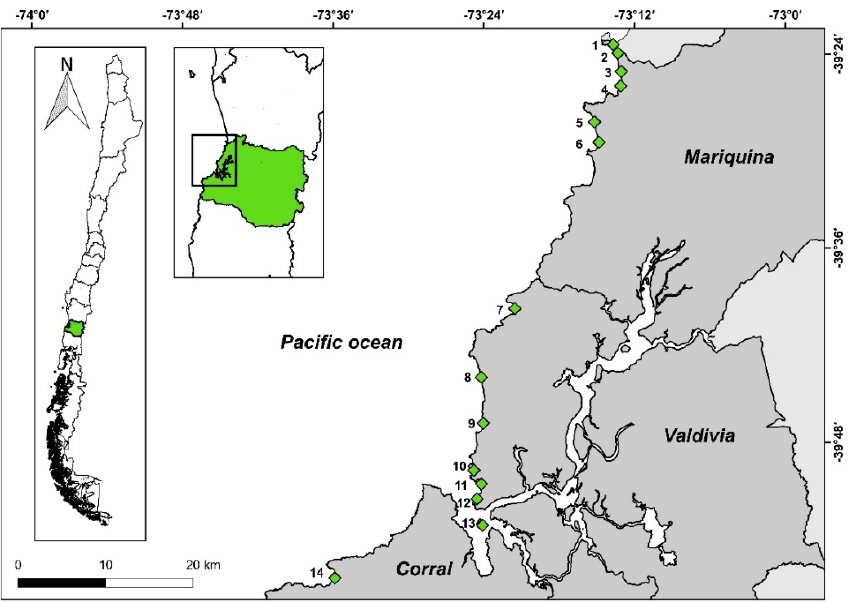
Figure 1. Location of the beaches sampled within the study area: (1) Ronca, (2) Cheuque, (3) Pich- Pichicuy í n, (4) Mehu í n, (5) Epuco, (6) Alepue, (7) Pilolcura, (8) Curiñanco, (9) Calfuco, (10) San icuyín, (4) Mehuín, (5) Epuco, (6) Alepue, (7) Pilolcura, (8) Curiñanco, (9) Calfuco, (10) San Ignacio, Ignacio, (11) Los Molinos, (12) Niebla, (13) Mancera, and (14) Chaihu í n. The insets show the location (11) Los Molinos, (12) Niebla, (13) Mancera, and (14) Chaihuín. The insets show the location of the of the study area within Los R í os region (green) and Chile. Vectorial data were obtained from study area within Los Ríos region (green) and Chile. Vectorial data were obtained from [39].